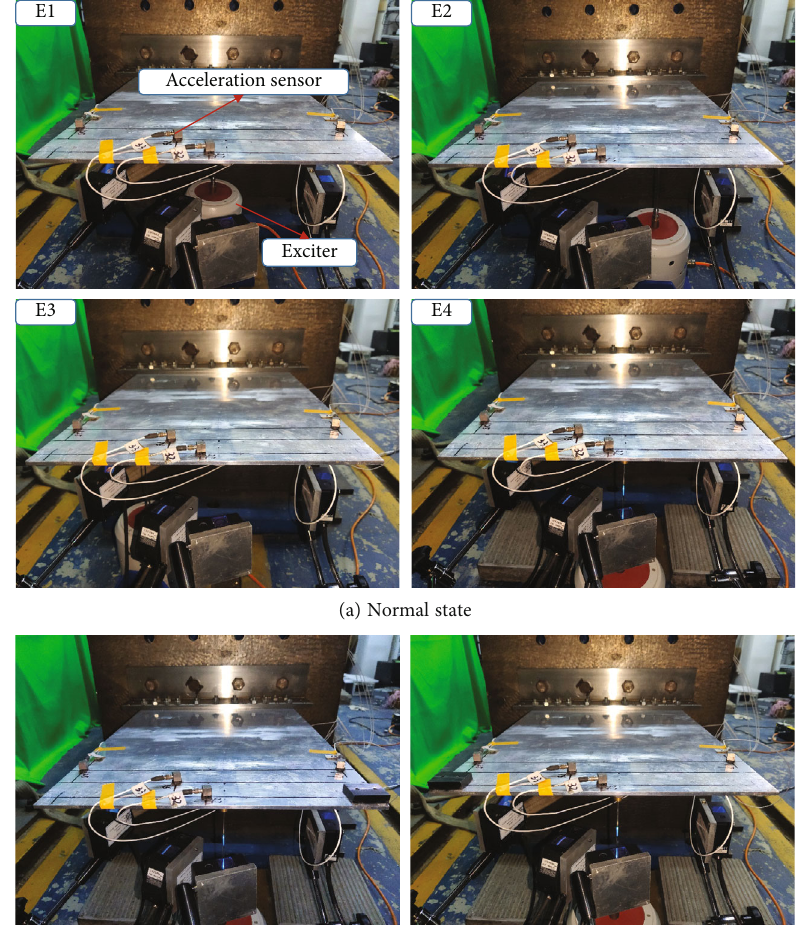
Figure 10: Ground test of the three